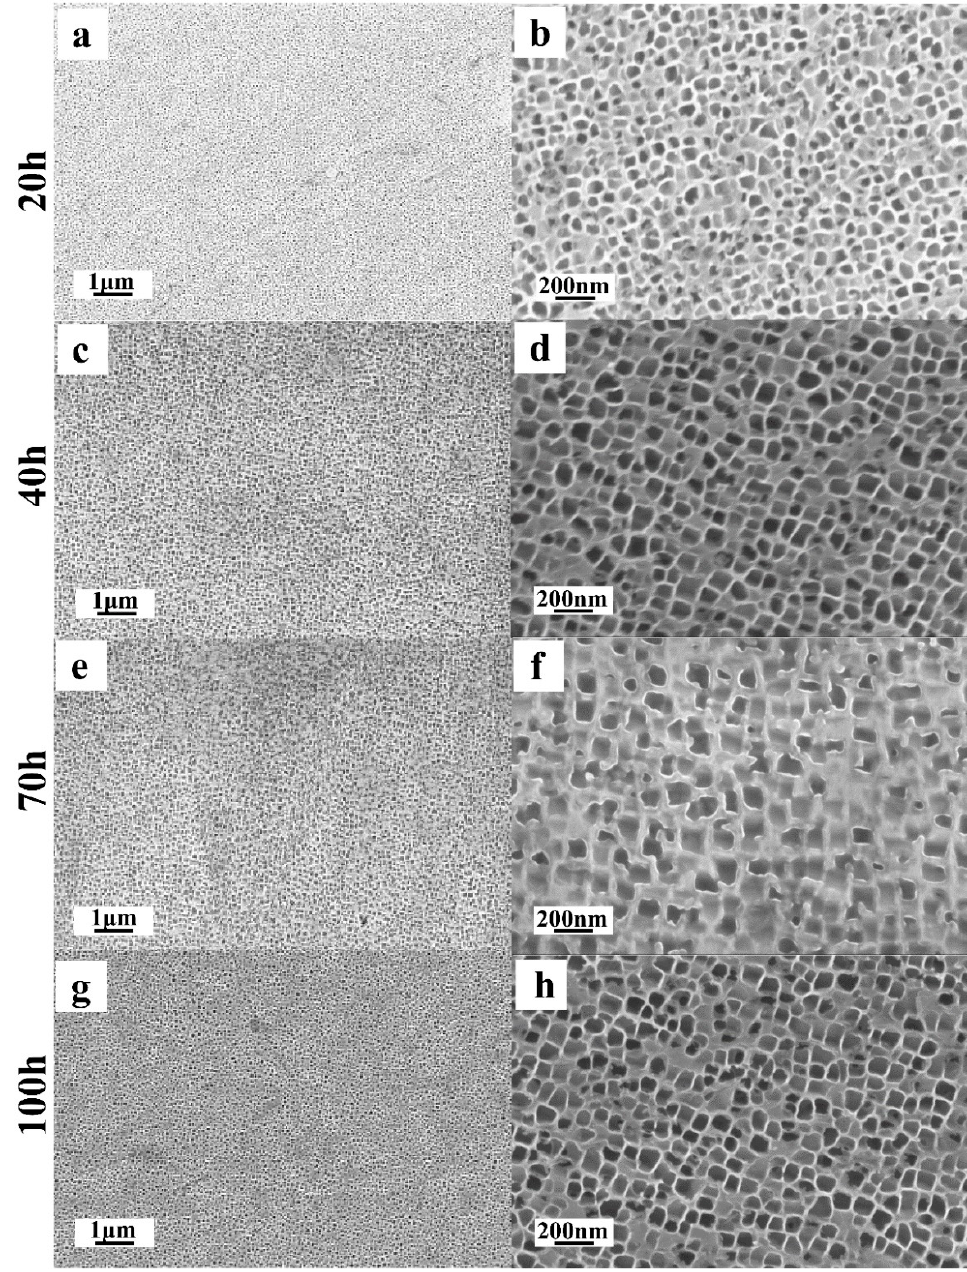
Figure 5. Microstructure of the tested alloy with creep mutation time of ( a , b ) 20 h ( c , d ) 40 h ( e , f ) 70